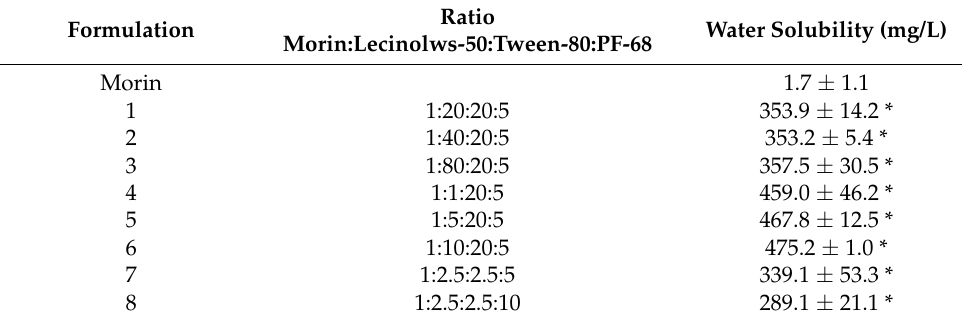
Table 3. Water solubility of liposomal morin compared to